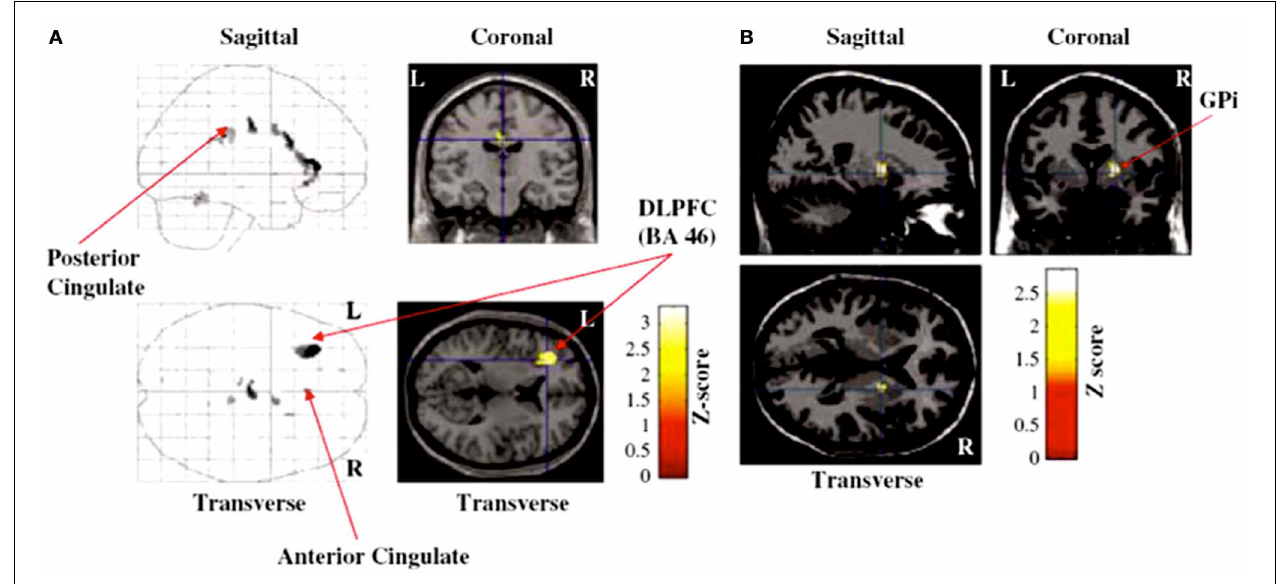
FIGURE 3 | Brain areas showing significant (A) decreased activation [dorsolateral prefrontal cortex (DLPFC), anterior cingulate cortex, posterior cingulate cortex] or (B) increased activation right internal segment of the globus pallidus (GPi) with subthalamic